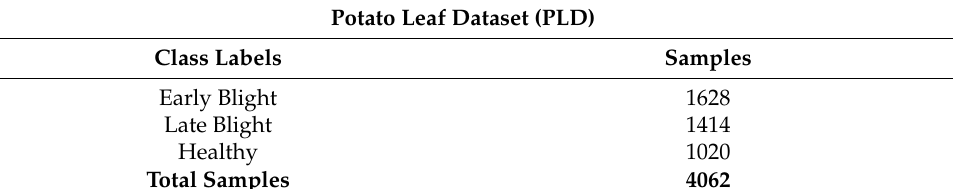
Table 4. Summary of PLD datasets.